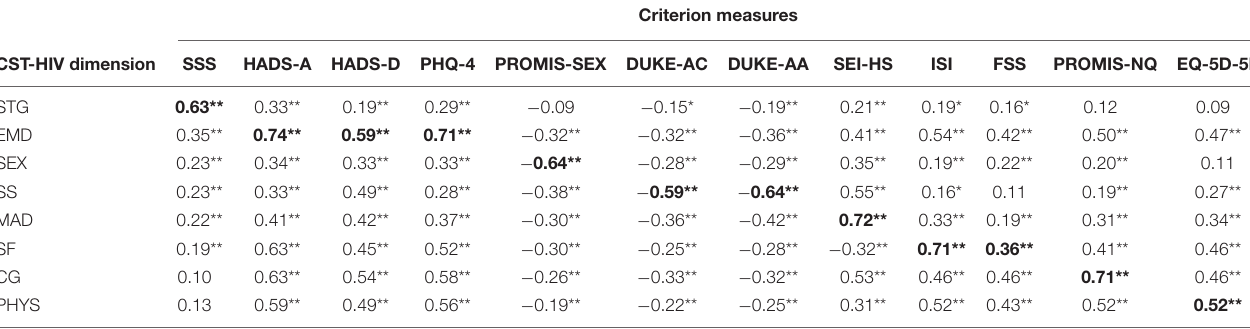
Criterion measures